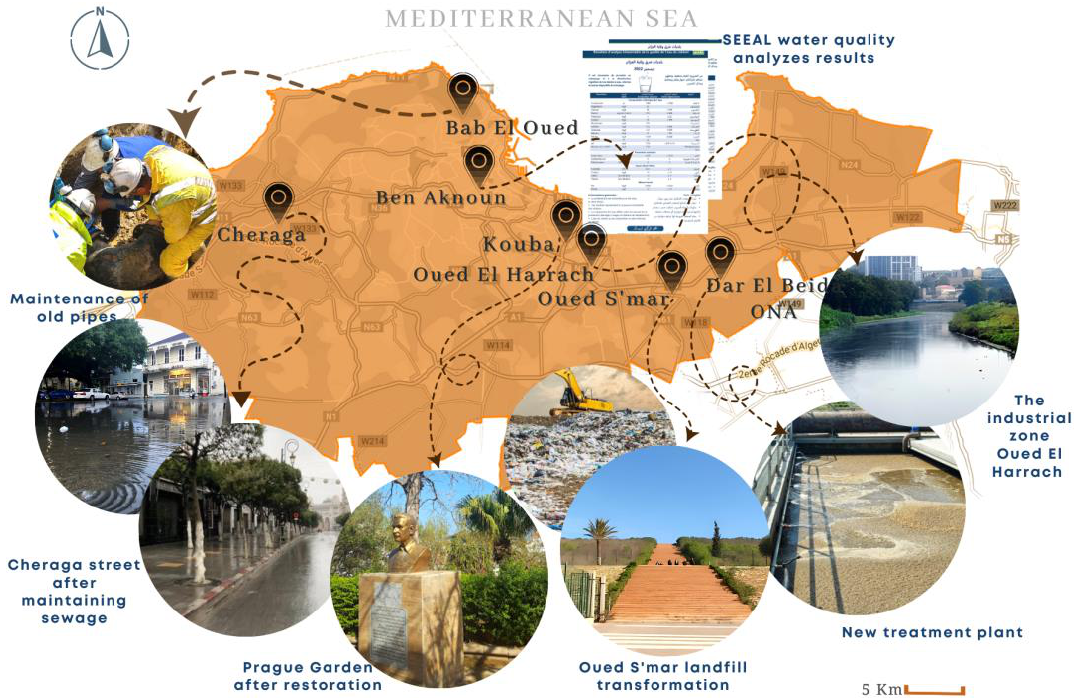
Figure 4. Key initiatives after COVID-19 in Algiers. Source: authors.